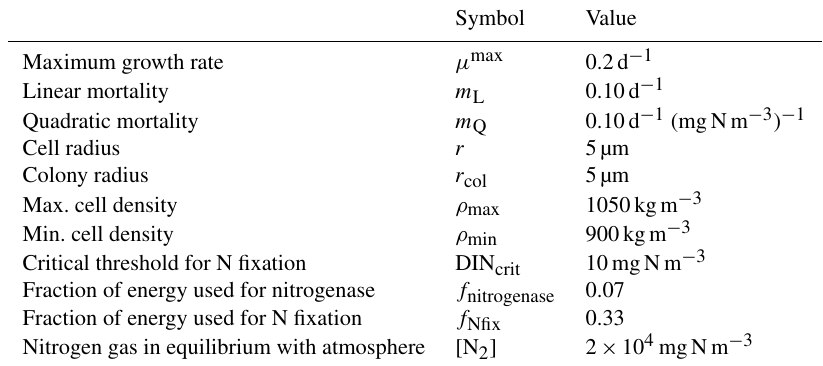
Table 7. Parameter values used in the Trichodesmium model (Robson et al.,